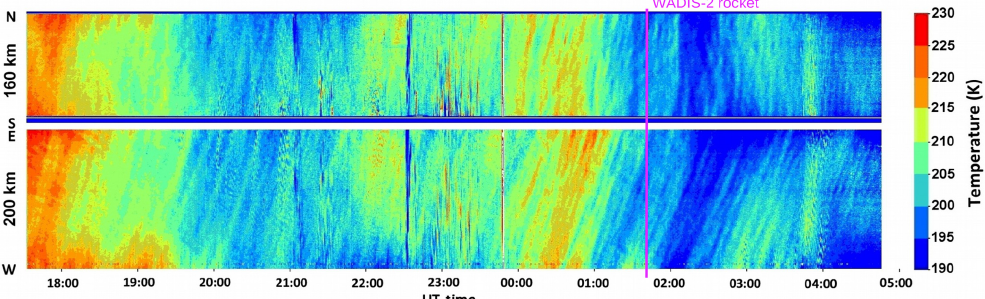
Figure 4. NS and WE keogram summary of the AMTM temperature measurements obtained during the night of 4 to 5 March 2015.